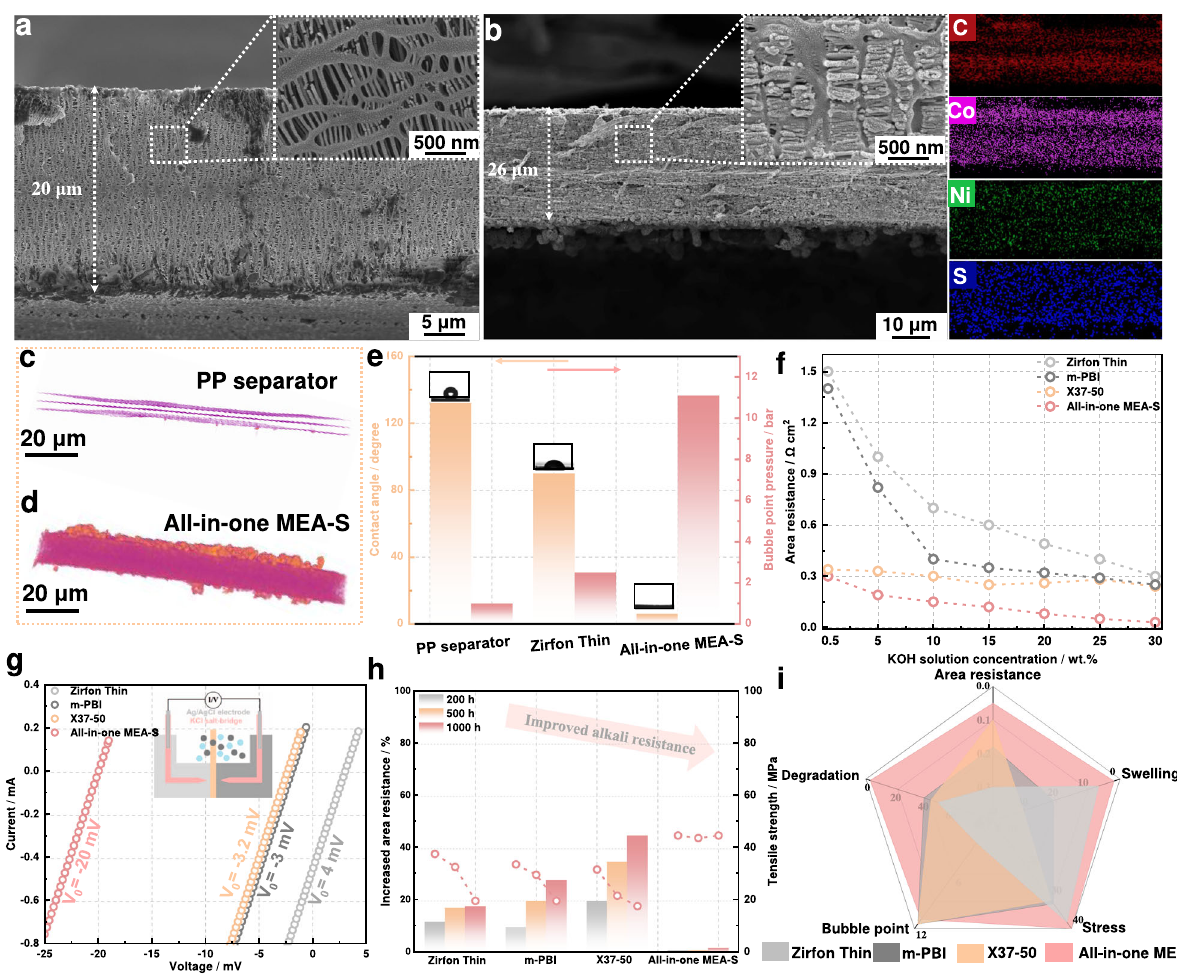
Fig. 3 | Basic properties inferred from membrane characterisation. Cross- sectionalSEM imagesof the a pristine PPporous separator and b all-in-one MEA-S, andcorrespondingelementalmapping.Inset:high-resolutionSEMimages.The3D- reconstruction image projection of the c pristine PP porous separator and d all-in- one MEA-S. e Contact angle and bubble point pressure of the pristine PP porous separator, Zirfon Thin and all-in-one MEA-S. f Area resistance of the commercial